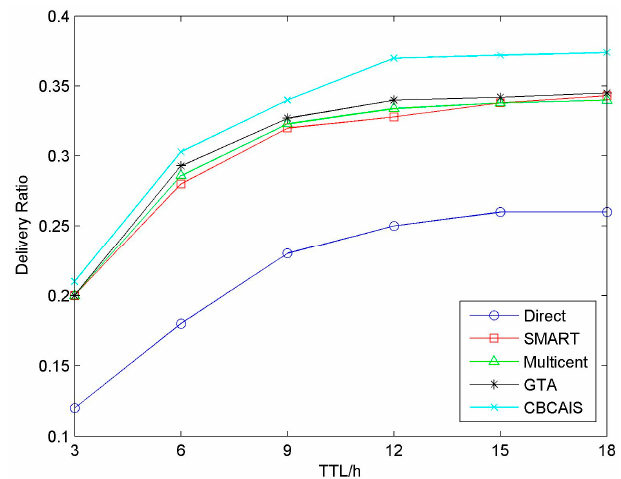
Figure 13. Delivery ratio for varying TTL.